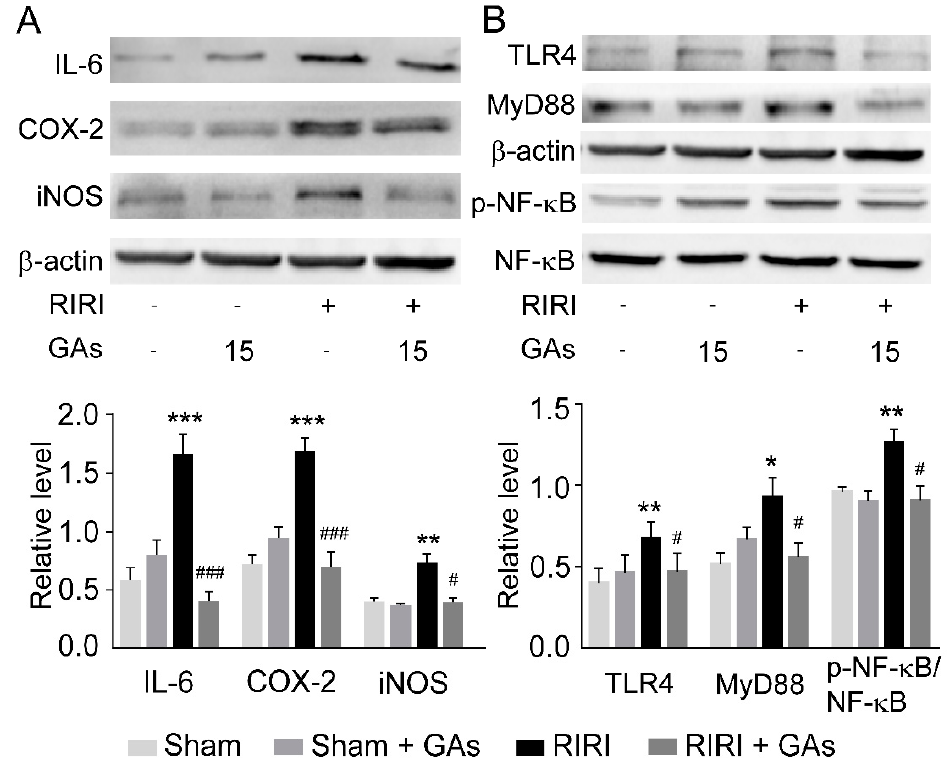
Figure 3. GAs attenuated RIRI-induced renal injury by suppressing inflammatory response. ( A ) Representative Western blots and the relative protein levels of IL-6, COX-2, and iNOS in the kidney. ( B ) Representative Western blots and the relative protein levels of TLR4, MyD88, and p-NF-kB in the kidney. The data of target proteins were normalized to b-actin as internal reference and are expressed relative to the intensity of the Saline + Sham group. Values are expressed as the mean ± SEM ( n = 4–6). * p < 0.05, ** p < 0.01 and *** p < 0.001 compared with Saline + Sham group; # p < 0.05 and ### p < 0.001 compared with Saline + RIRI group (two-tailed Student’s t -test or one-way ANOVA).